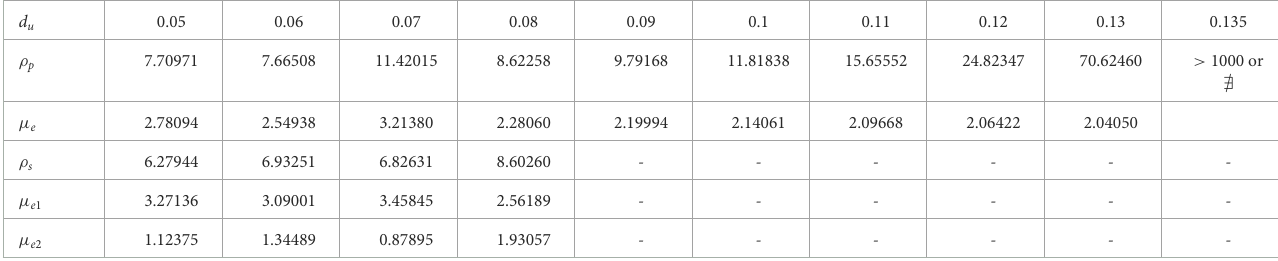
TABLE 1 Numerical values (rounded to 5th decimal place) of the subcritical (or supercritical) pitchfork bifurcation point ρ p , the fold bifurcation point ρ s , and the associated values for the symmetric µ e and one of the asymmetric ( µ e 1 , µ e 2 ) solution